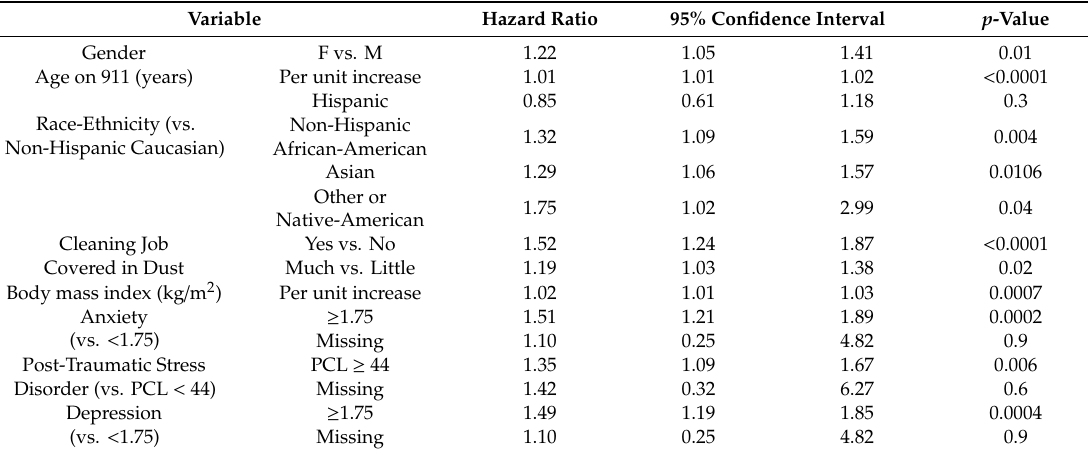
Table 4. Multivariable Cox proportional hazards regression using Baseline and Return Visit data, excluding subjects with “occasional” paresthesia ( n = 2407). Variable Hazard Ratio 95% Confidence Interval p